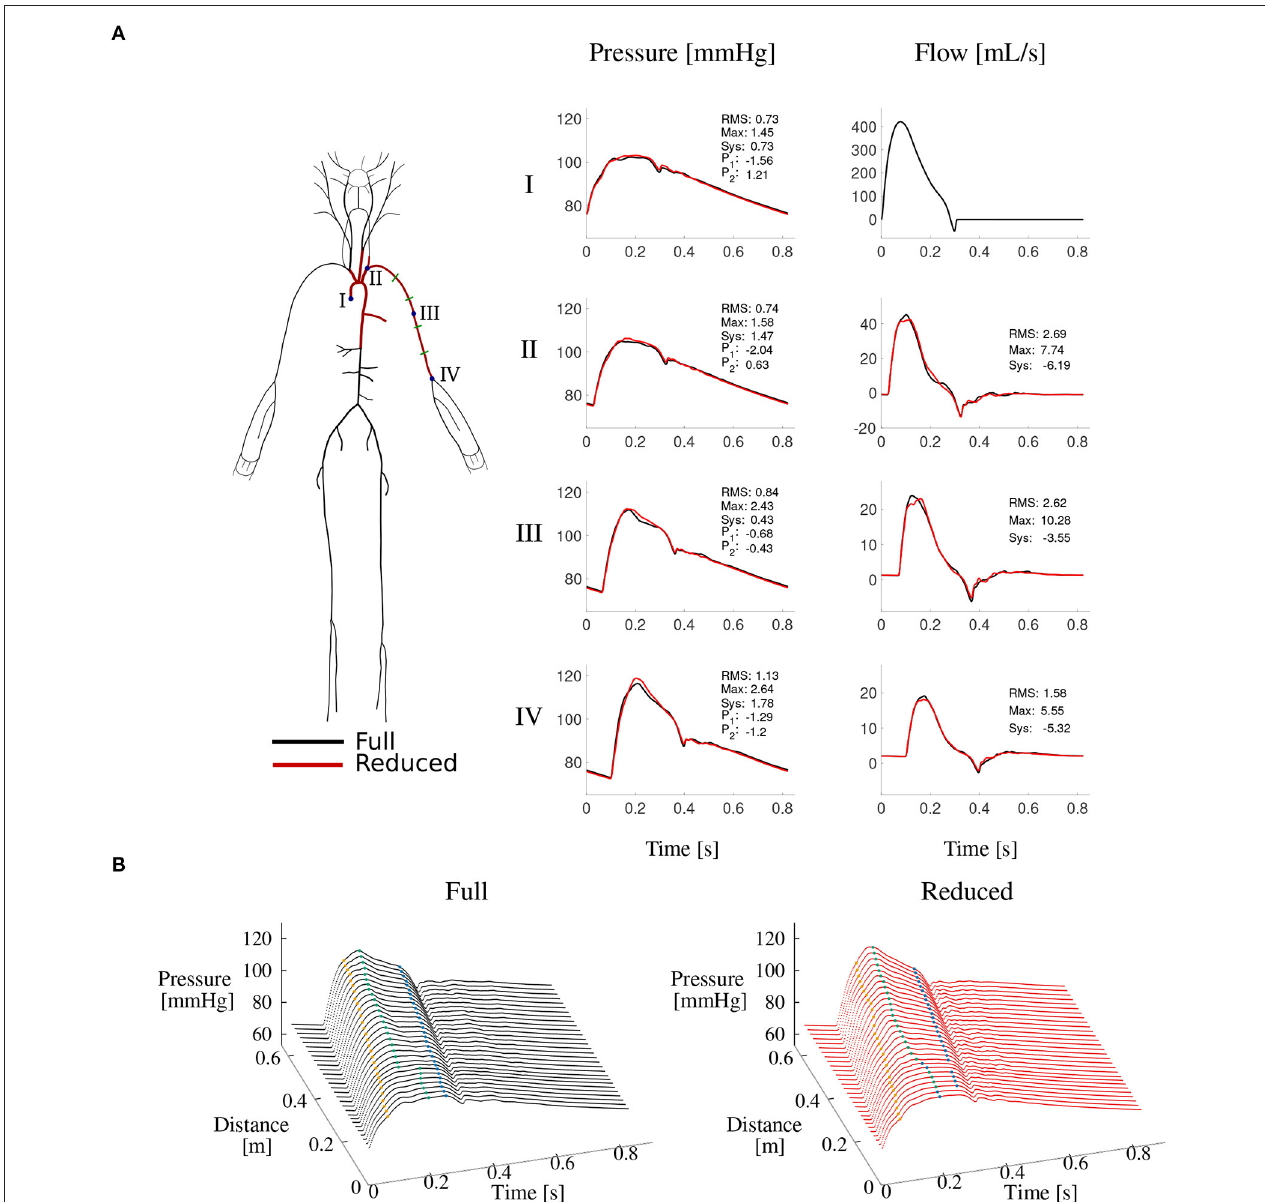
FIGURE 3 | Reduced vs. full model pressure and flow waves. (A) Schematic representations of both models (left) and comparison of corresponding pressure and flow waves at four locations along the aortic-brachial arterial path (right). Each plot shows relative errors (expressed as percentages) for average (RMS), maximum (Max), systolic (Sys) and characteristic pressure points P 1 and P 2 calculated as described in Supplementary Section 1 . (B) Pressure wave along the same arterial path, for the full (left) and reduced (right) model. Characteristic pressure points P 1 (yellow), systolic pressure (green), and P 2 (blue) are shown in each